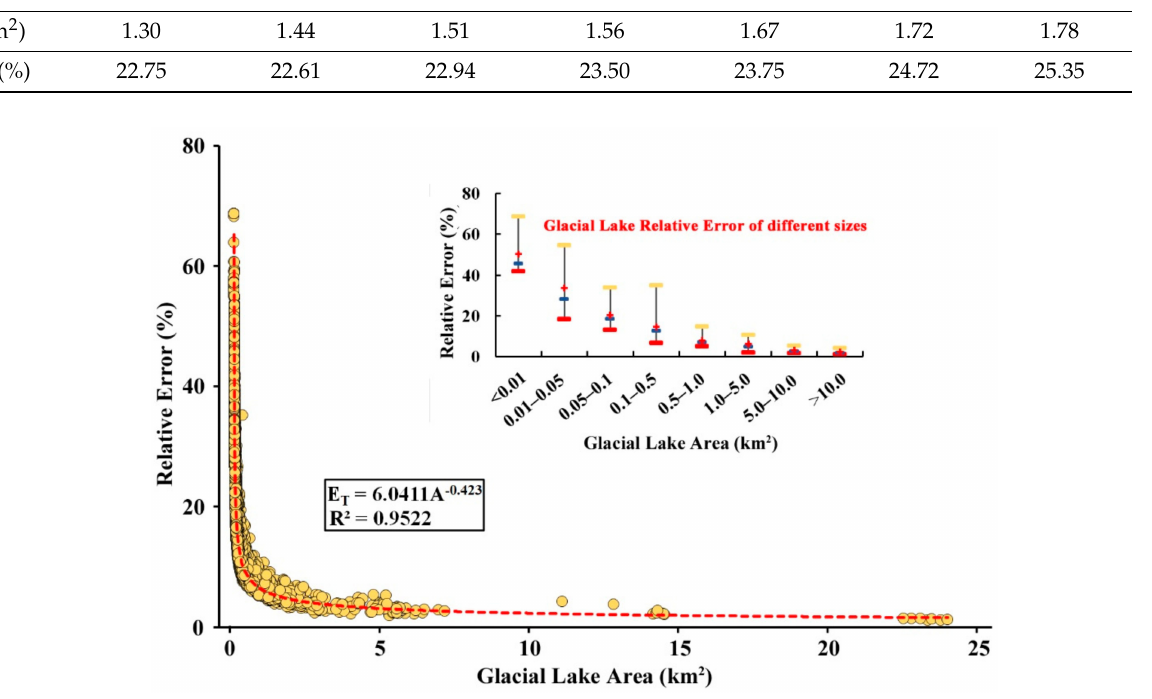
Figure 3. Relationship between the areas and relative errors of glacial